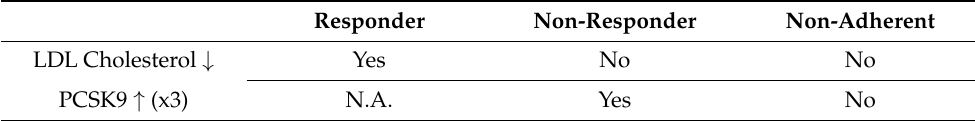
Table 4. Proposed evaluation for PCSK9 antibody adherence. Responder Non-Responder Non-Adherent LDL Cholesterol ↓